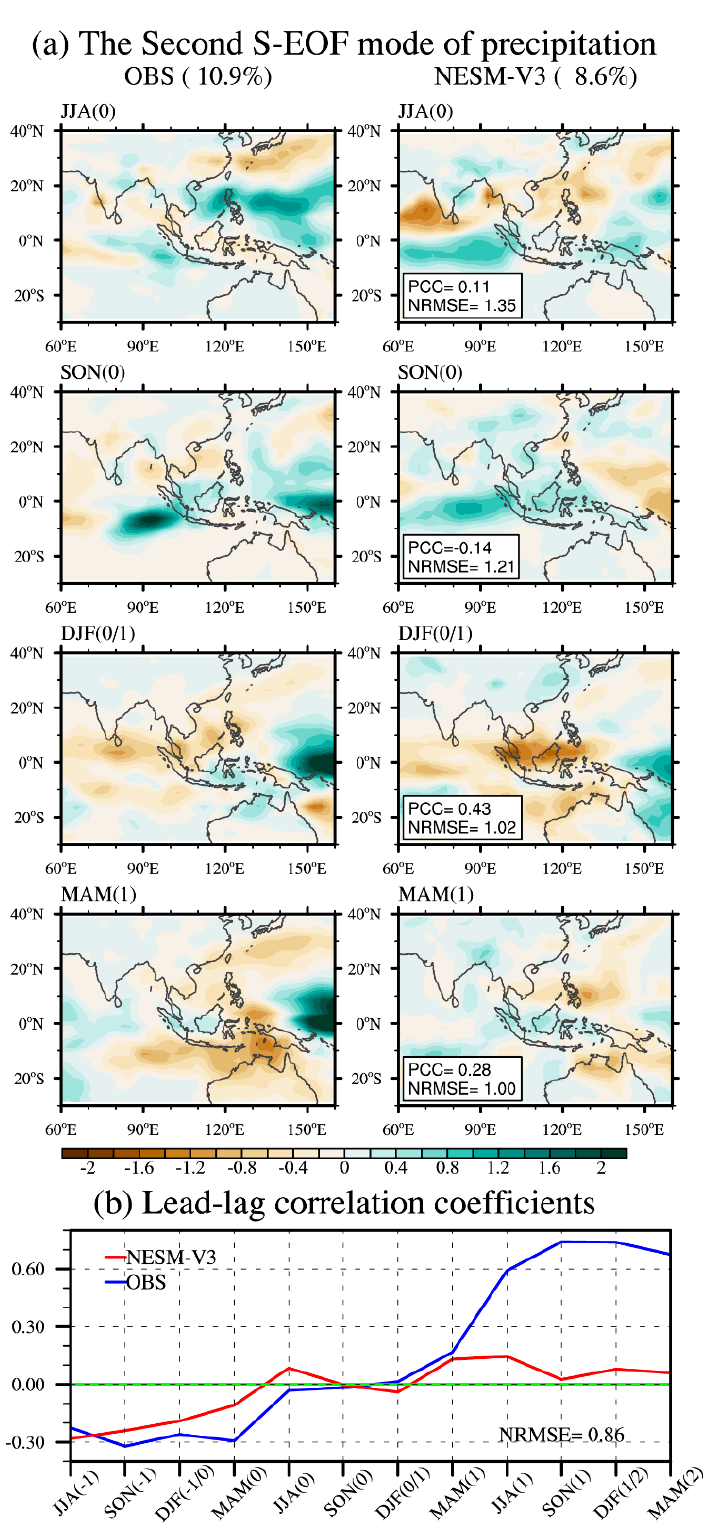
Figure 6. Same as in Figure 4, except for the second SEOF.